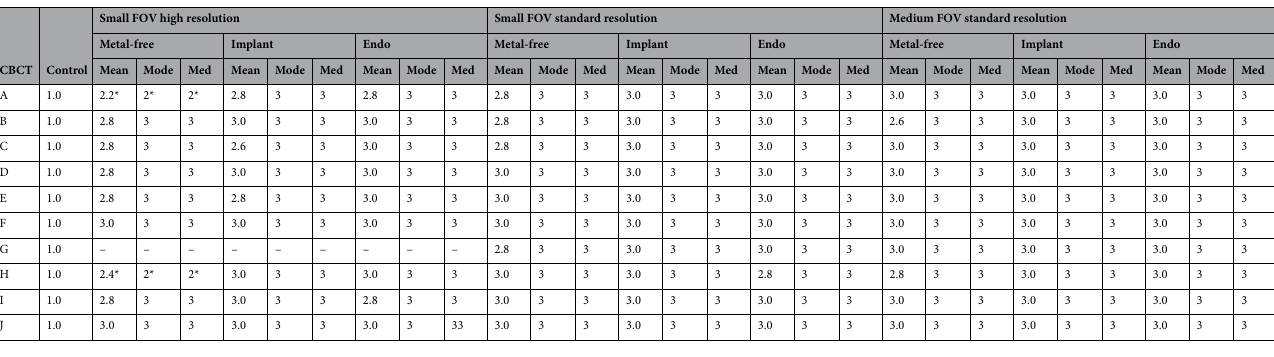
Table 2. Mean, mode and median (med.) values of visualization assessment of root cracks (1—appropriate, 2—acceptable and 3—inappropriate) considering scanning protocols and conditions. *Statistical similarity with the reference industrial CT scan, which is shown as ‘Control’ (1.0—appropriate for visualizing the root crack).